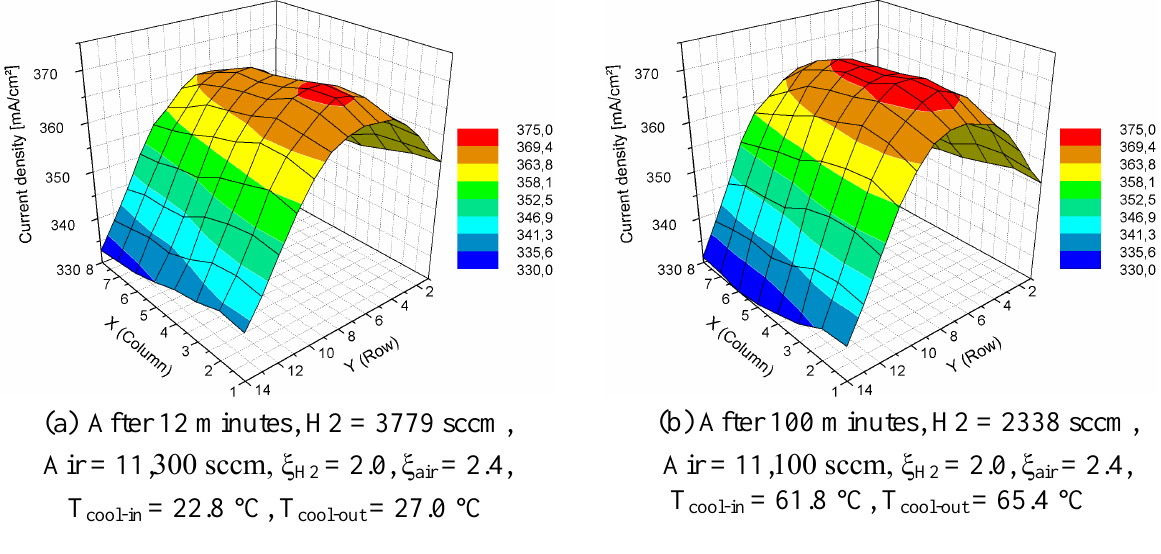
Figure 13. Measured current density distributions during the warm up phase.